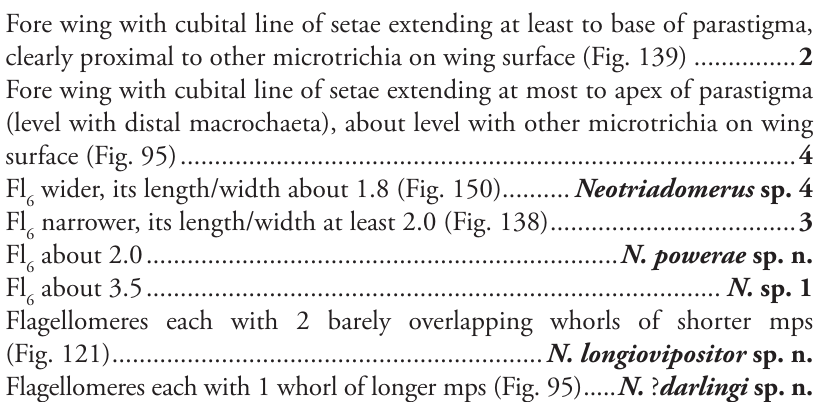
Males of darlingi , longiovipositor and powerae are known and almost certainly correctly associated with the corresponding females; males are unknown for N. burwelli , N. crassus , N. gloriosus and N. longissimus . Two unnamed males are also keyed; one (sp. 4) is not definitely associated with a female and the other (sp. 1) is definitely associated with a